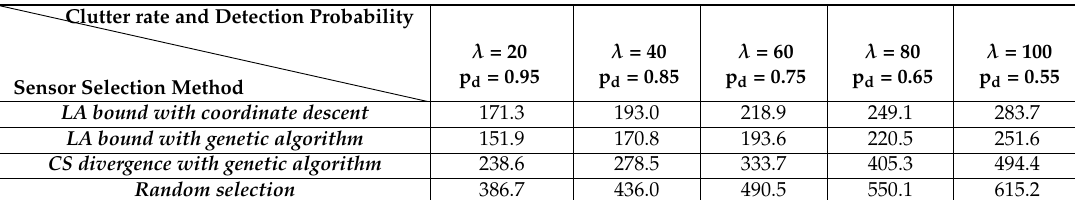
Table 1. Final value of OSPA error (Unit: m).